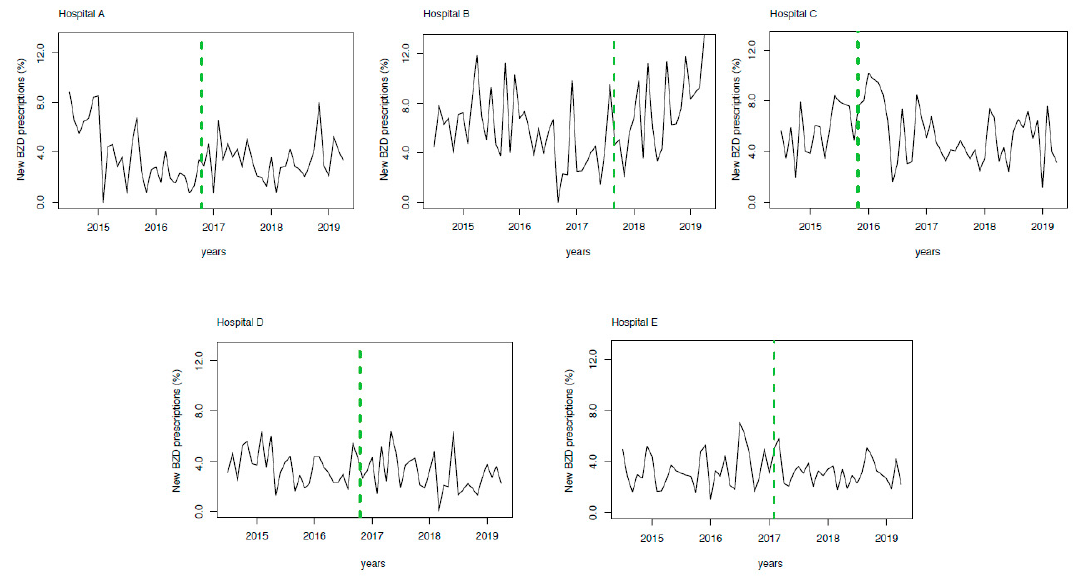
Figure 1. Benzodiazepine (BZD) prescriptions by hospitals before and after the e-prescribing tool implementation. Monthly rate of new BZD prescriptions during the period before and after the e-prescribing system implementation in hospitals A–E. Dashed green lines indicate the e-prescribing implementation start for each hospital.